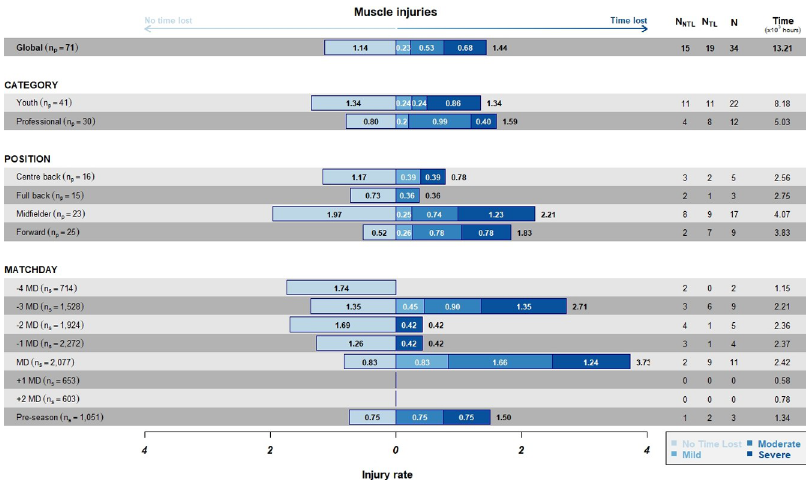
Fig 3. Incidence of TL and NTL injuries per 10 3 h of exposure stratified by category, position, and days to/from the match. Numbers inside bars represents the incidence according to the severity. https://doi.org/10.1371/journal.pone.0263494.g003 The incidence of TL injuries was higher on MD (3.71x10 3 h), followed by -3MD (2.71x10 3 h). As for categories, the highest values were reported in professionals (1.59x10 3 h), in comparison to youth (1.34x10 3 h). Finally, as for positions, the highest rate was observed among midfielders (2.21x10 3 h), followed by forwards (1.82x10 3 h). Muscle injury incidence per HMLD. The overall incidence of muscle injuries per 10 5 m of HMLD (Fig 4) was similar to the incidence per hours of exposure: the highest incidence was observed on -3MD (0.41x10 5 m), followed by MD (0.29x10 5 m) and preseason. Moreover, over- all incidence of muscle injuries per 10 5 m of HMLD was higher in the professional category (0.25x10 5 m) than in the youth (0.20x10 5 m); and midfielders presented the highest values (0.35x10 5 m), followed by forwards (0.27x10 5 m).